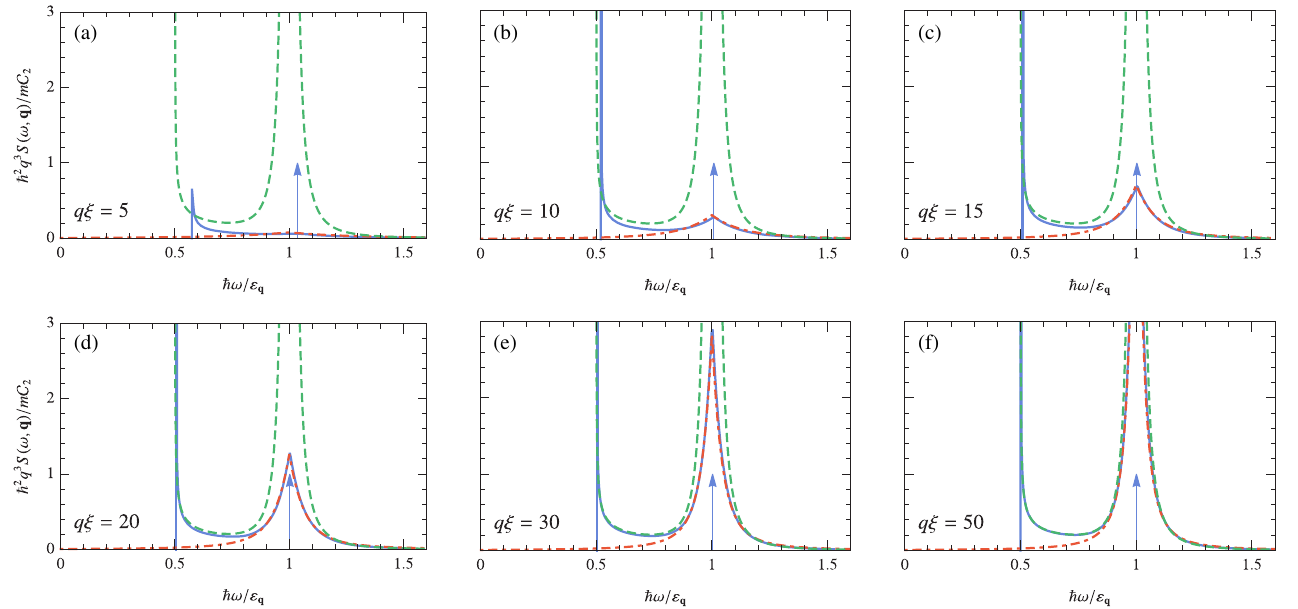
FIG. 8. Dynamic structure factor as a function of frequency for increasing momentum q ξ ¼ 5 , 10, 15, 20, 30, and 50 [(a) – (f)] (continuous blue lines). The plots clearly show the crossover to the universal scaling form predicted by the OPE (dashed green lines) at high momentum, shown in full in Fig. 3. Near the one-particle peak, the dynamic structure factor is described accurately by the impulse approximation (red dot-dashed line). The vertical arrows (not to scale) indicate the position of the condensate delta peak on top of the incoherent background, which here is centered at the Bogoliubov energy E q ¼